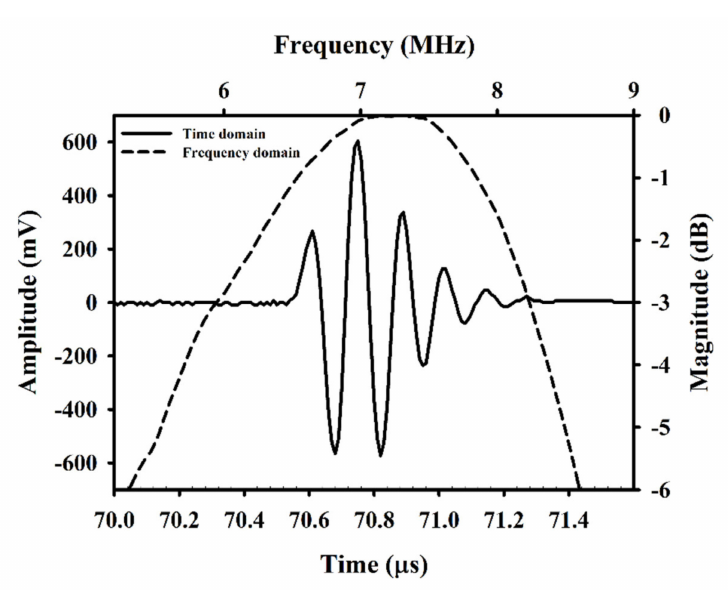
Figure 1. Schematic diagram of the ultrasound imaging system.